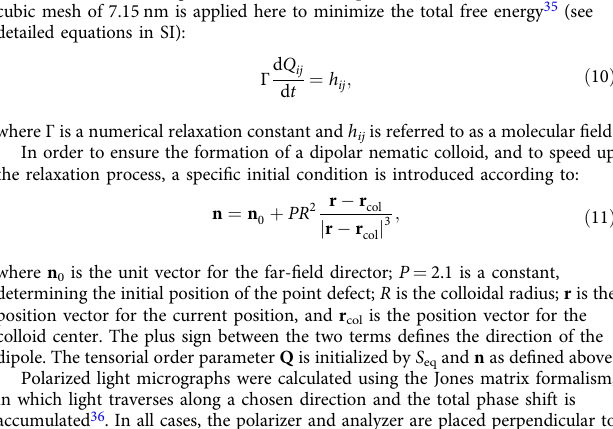
where n 0 is the unit vector for the far- fi eld director; P = 2.1 is a constant, determining the initial position of the point defect; R is the colloidal radius; r is the position vector for the current position, and r col is the position vector for the colloid center. The plus sign between the two terms de fi nes the direction of the dipole. The tensorial order parameter Q is initialized by S eq and n as de fi ned above. Polarized light micrographs were calculated using the Jones matrix formalism, in which light traverses along a chosen direction and the total phase shift is accumulated 36 . In all cases, the polarizer and analyzer are placed perpendicular to each other, with the polarizer parallel to the z- axis. The light wavelength used in this work is 351 nm. The following numerical parameters were used: A = 1.17 × 10 5 Jm − 3 , U = 3.5, L = 6× 10 − 12 N, W = 10 − 3 Jm − 2 , unless speci fi ed otherwise. The channels in this c work have periodic boundaries along the x and y axes, and rigid homeotropic anchoring along the z -axis.